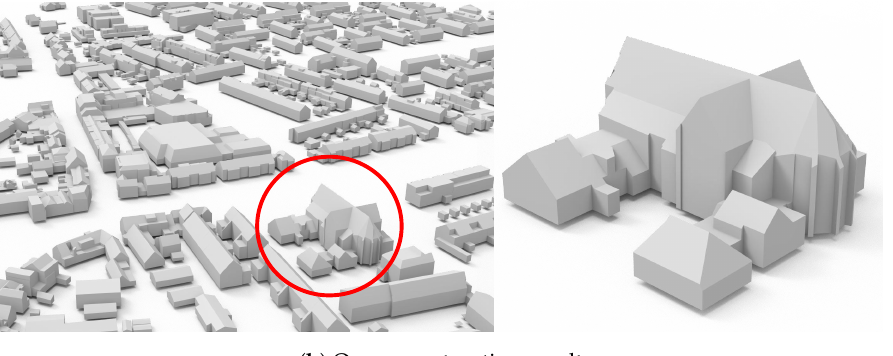
Figure 1. The automatic reconstruction result of all the buildings in a large scene from the AHN3 dataset